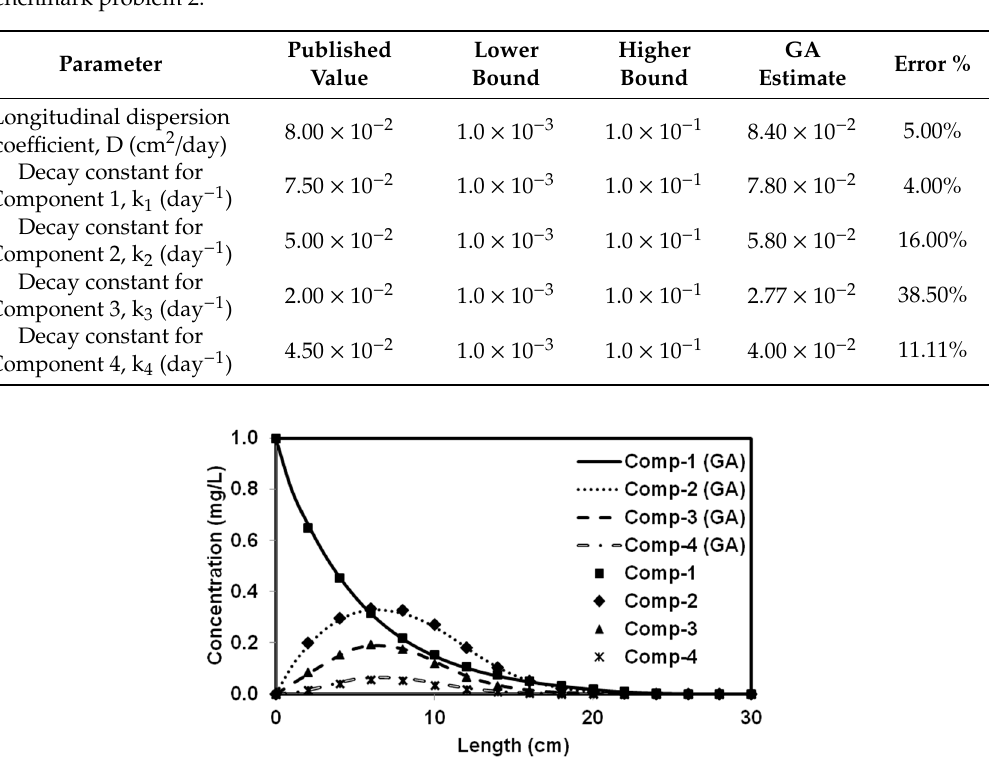
Figure 3. Comparison of results from PGA-estimated parameters and the published parameters for benchmark problem 2.